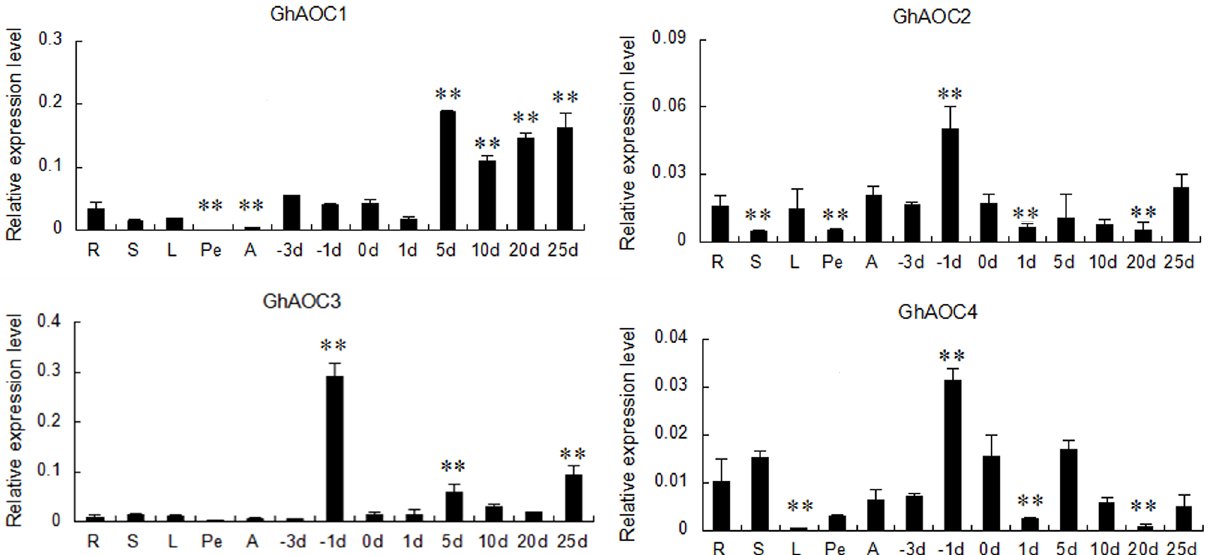
Fig 5. AOCs expression in different tissues and organs in TM-1. R, S, L, Pe, A, -3d, -1d, 0d, 1d, 5d, 10d, 20d, and 25d indicate root, stem, leaf, petal, anther, -3, -1, 0, 1 and 3 DPA ovules and 5, 10, 20 and 25 DPA fibers, respectively. Significant differences compared with the expression in root tissue at the 0.05 and 0.01 probability levels are represented by * and ** , respectively. Error bars indicate ± SD of triplicate experiments. Three biological replicates were used for